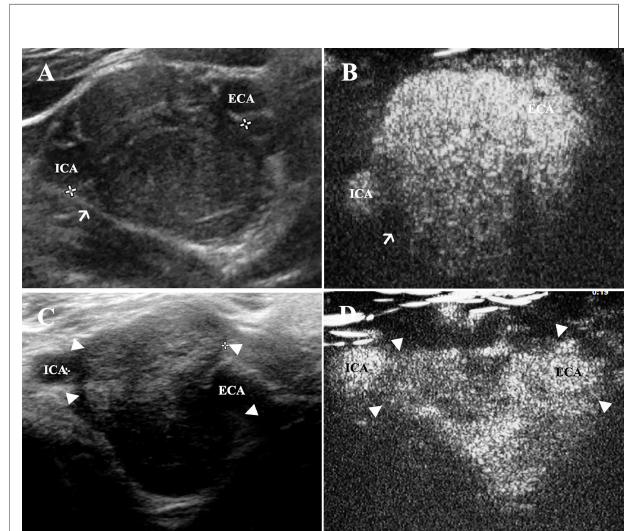
FIGURE 4 | CEUS is superior to assess the morphology of CBT lesions in comparison to gray-scale ultrasound. (A) CBT lesions presented as oval-shaped and hypoechoic masses, which led to splaying of the carotid bifurcation. The adventitia of carotid vessels could be observed clearly on gray-scale ultrasound (thin arrow). (B) However, the adventitia (thin arrow) could hardly be visualized in CEUS during the artery phase. (C) A very small part of ICA was encased by the lesion area. The margin (triangles) of the tumor around ECA could not be seen clearly, and a Shamblin type II was identi fi ed using grey-scale ultrasound. (D) The margin of the tumor (triangles) could be better observed using CEUS and a Shamblin type III was reclassi fi ed. CBT, carotid body tumor; CEUS, contrast-enhanced ultrasonography; ICA, internal carotid artery; ECA, external carotid